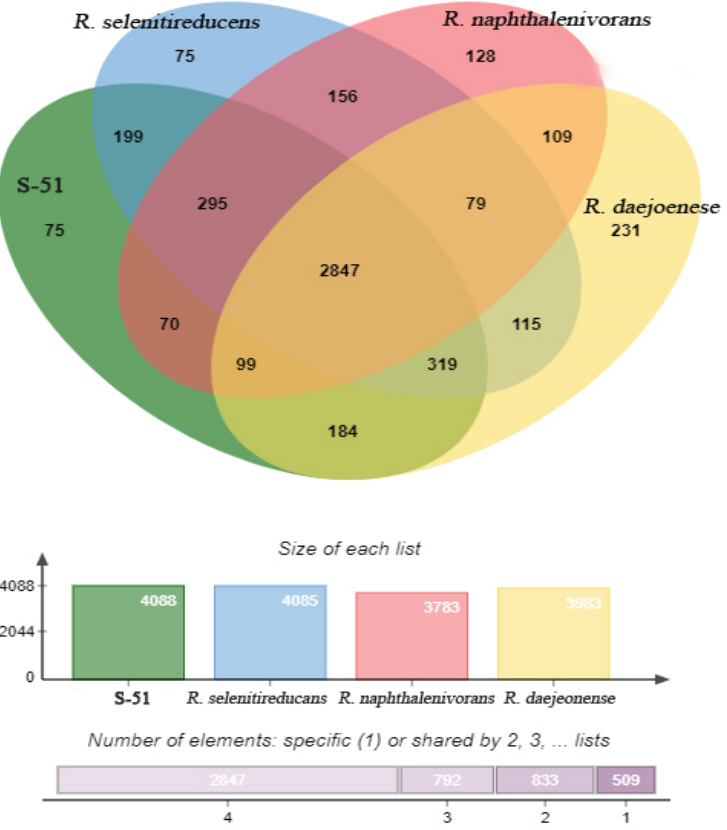
Figure 5. Venn diagram of whole-genome orthologous genes in S-51 T and three type species of reference strains ( Rhizobium selenitireducens , Rhizobium naphthalenivorans , and Rhizobium daejeonense ). The numbers in the diagram indicate overlapped conserved genes or non-overlapped unique genes in each